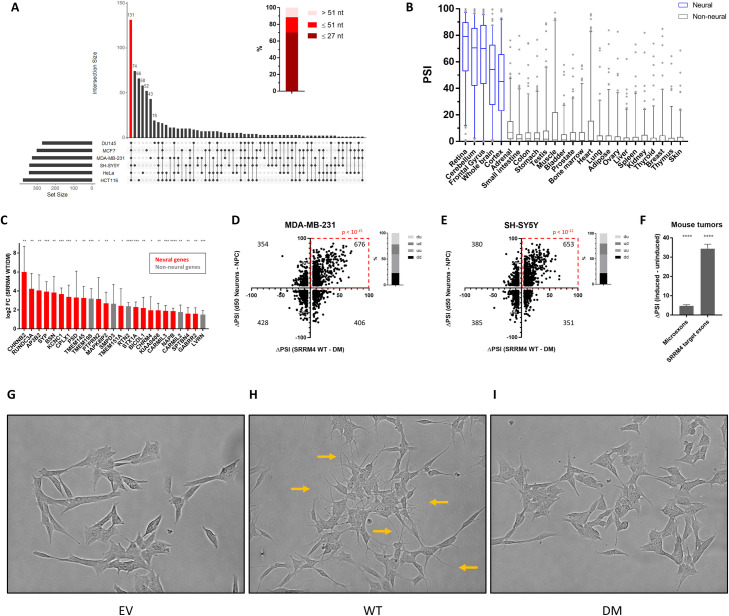
SRRM4 expression leads to neural-like expression and splicing patterns and morphological changes in cancer cells.(A) Exons with increased inclusion in all 6 cell lines after SRRM4 induction (ΔPSI ≥ 25). Inset: nucleotide lengths of the 131 shared exons, demonstrating a majority are microexons. The cell lines comprising each intersection set are indicated below each bar. Figure was generated using UpSet package in R. (B) Box plots of the PSIs of the 131 SRRM4-regulated exons shared between the 6 cell lines across tissue types (from VastDB). Boxes expand from the first to the third quartile, with the center values indicating the median, and whiskers extend from 5 to 95 percentile. (C) Genes with increased expression in all 6 cell lines after SRRM4 induction (fold change ≥2 compared to DM control). Bars represent the mean fold change values, with error bars representing 95% CI. Red bars are genes with known neuronal function (GO: nervous system development) and/or neural-specific expression patterns. Fold change values shown are significantly different from 0 (1-sample t test, 2-tailed; *p < 0.05, ** p < 0.01, *** p < 0.001, **** p < 0.0001). (D, E) Overlap between changes in exon inclusion with neuronal differentiation dataset after 7 d of SRRM4 induction in (D) MDA-MB-231 or (E) SH-SY5Y (p-values shown from binomial test). (F) Changes in inclusion of microexons (≤27 nt) and SRRM4 target exons between the doxycycline-induced and uninduced mouse tumors. Bars represent the mean ΔPSI of the sets of exons, with error bars representing 95% CI. The mean ΔPSI for both sets of exons was significantly different than 0 (1-sample t test, 2-tailed; **** p < 0.0001). (G, I) SH-SY5Y cells were transduced with (G) EV, (H) WT SRRM4, or (I) DM SRRM4. Cell images were taken after 7 d induction with 1 μg/mL doxycycline. WT SRRM4-expressing cells develop numerous membrane projections (orange arrows). Results shown are representative of 3 independent experiments. Data underlying Fig 7A–7F can be found in S1 Data figures. DM, deletion mutant; EV, empty vector; GO, gene ontology; nt, nucleotide; PSI, percent spliced in; SRRM4, Serine/Arginine Repetitive Matrix 4; WT, wild-type.